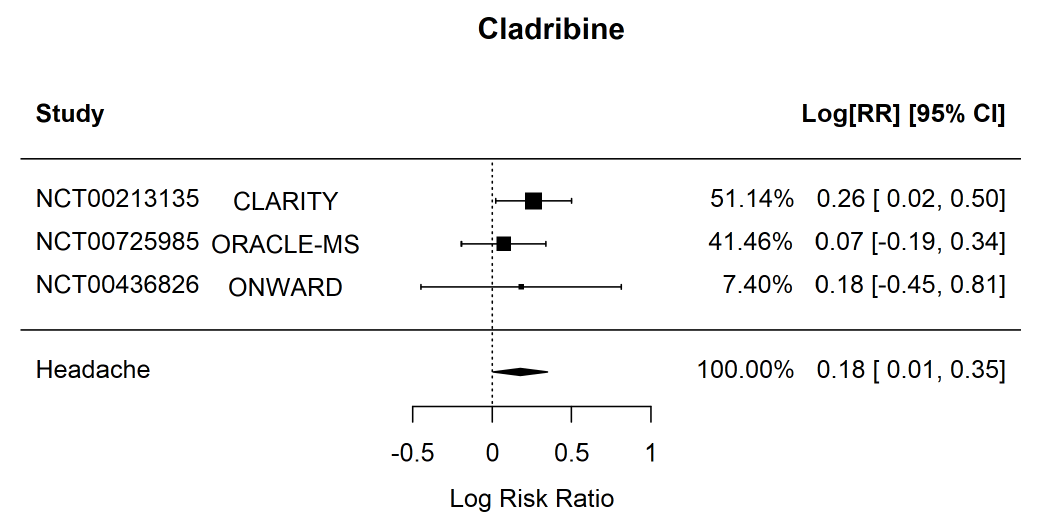
Figure 3. Forest plot of sub-group analysis for the association of headache with Cladribine treatment. NCT: clinicaltrials.gov registration number, RR: Risk Ratio, CI: Confidence Interval.